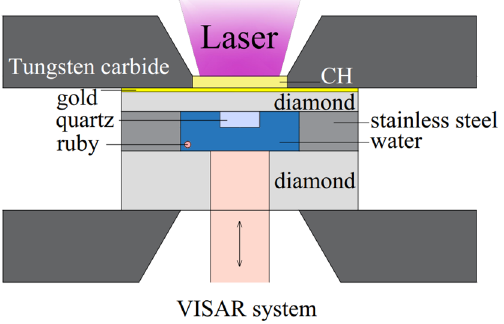
Figure 1. A schematic of experimental setup for laser shock compression of precompressed water in a DAC. For the DAC precompression, the fluorescence peak of ruby is used to infer the initial pressure. For the laser shock compression, a VISAR is used to determine both the Hugoniot state and the sound speed.